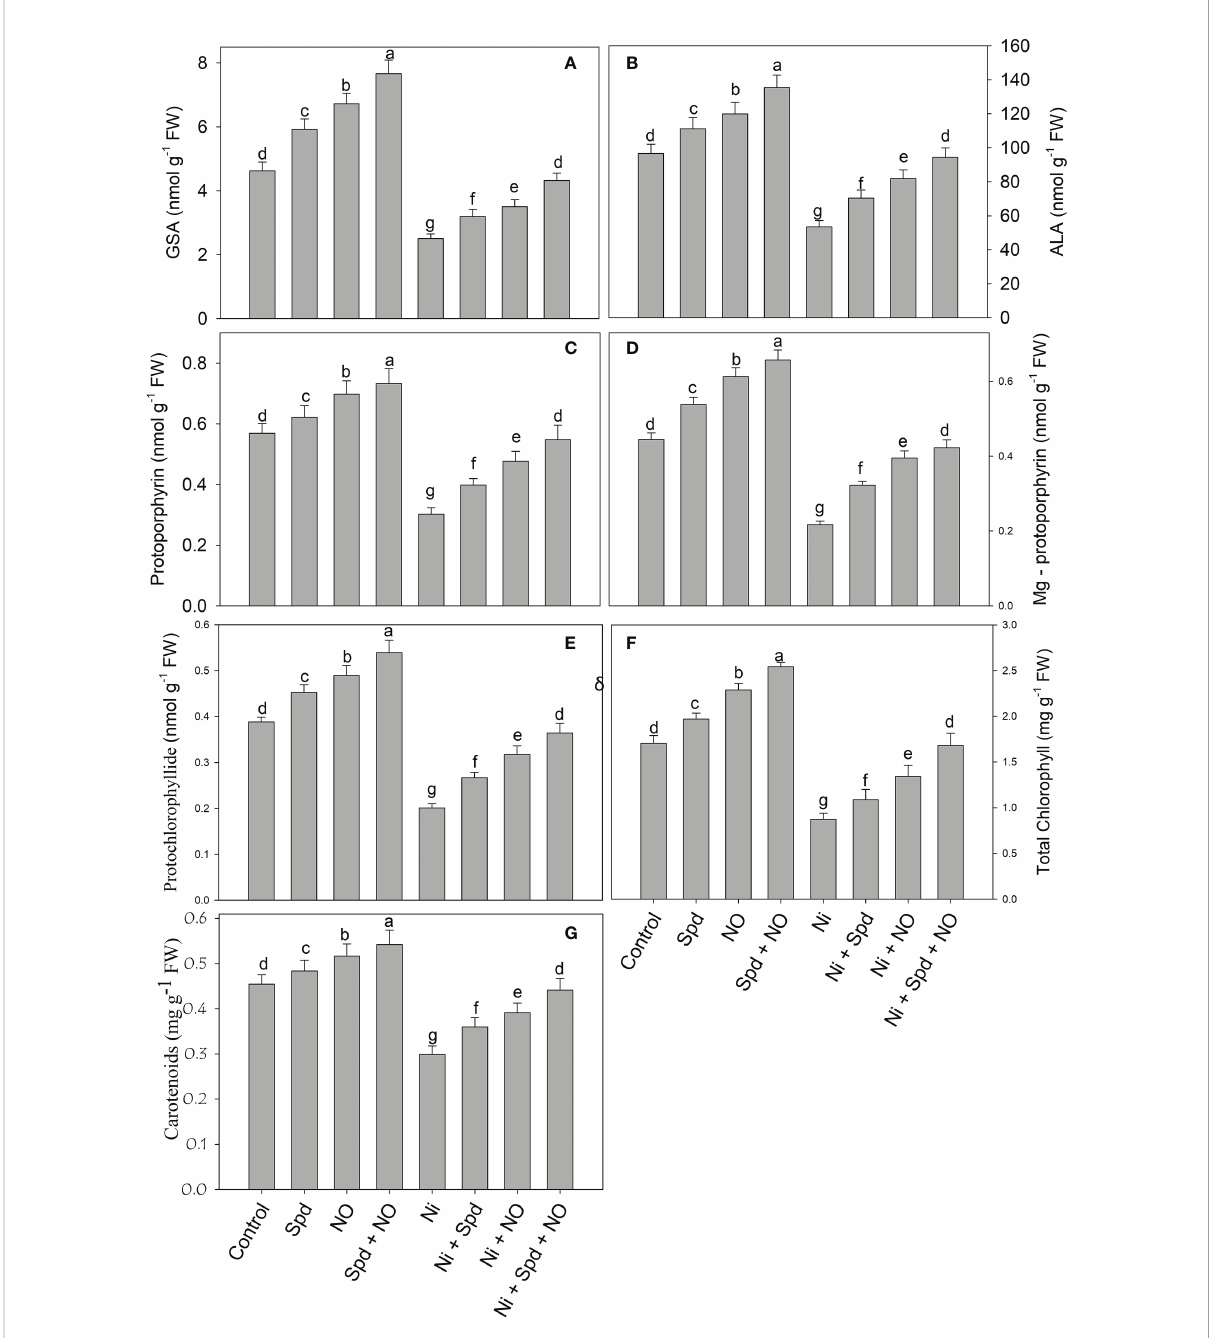
FIGURE 1 Effect of nitric oxide (50 µM) and spermidine (100 µM) supplementation on (A) glutamate 1-semialdehyde, (B) d -amino levulinic acid, (C) prototoporphyrin IX, (D) Mg-prototoporphyrin IX, (E) protochlorophyllide (Pchlide), (F) total chlorophyll and (G) carotenoids content in Solanum lycopersicum L. subjected to nickel stress. Data is mean (±SE) offour replicates and different letters on bars denote signi fi cant difference at P <